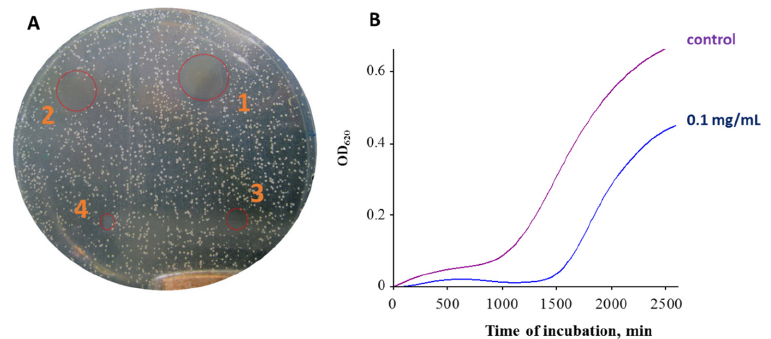
Figure 3. Two basic methods of screening of the antibacterial effect: ( A ) Effect of AgNPs in concentrations of 5 (1), 2.5 (2), 1.25 (3) and 0.625 mg/mL (4) in the agar plate disk diffusion test on S. aureus cells after 24 h of incubation. Growth inhibition zones are marked by red circles. ( B ) The growth curve of S. aureus without (control) or with 0.1 mg/mL AgNPs showed optical density of 620 nm (OD 620 ), dependent on the time of growth.